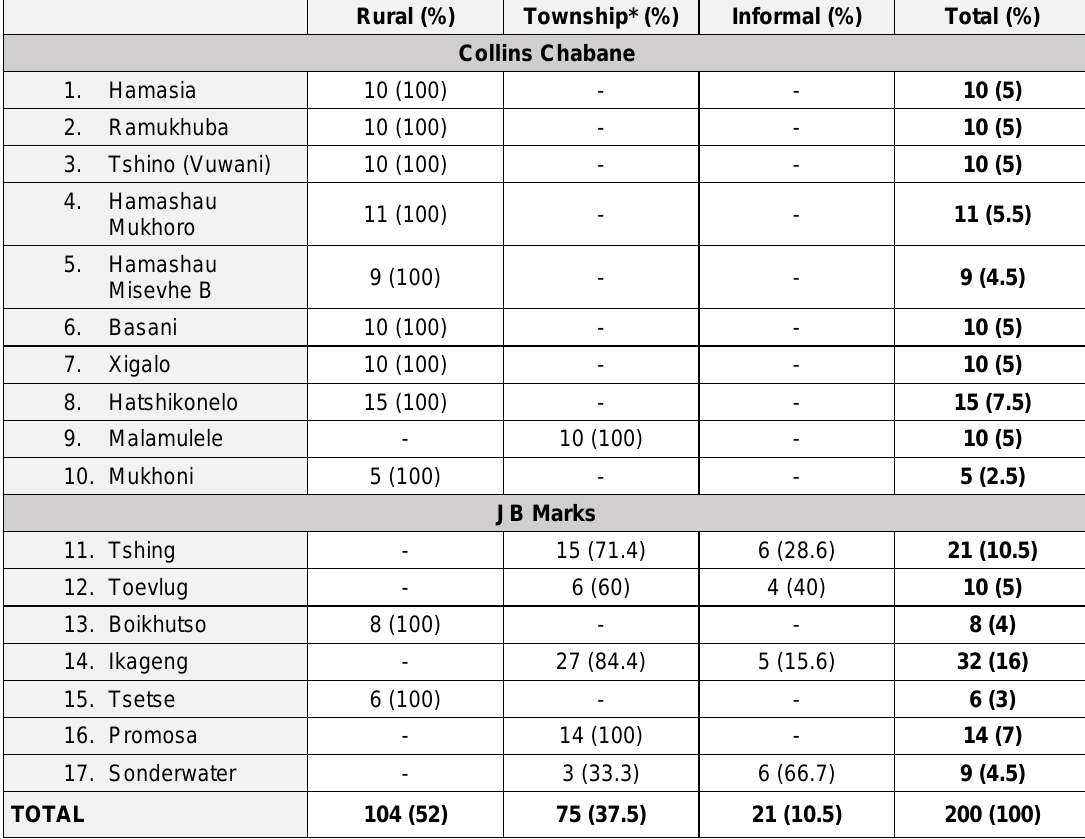
Table 4: Numbers of participants and settlement